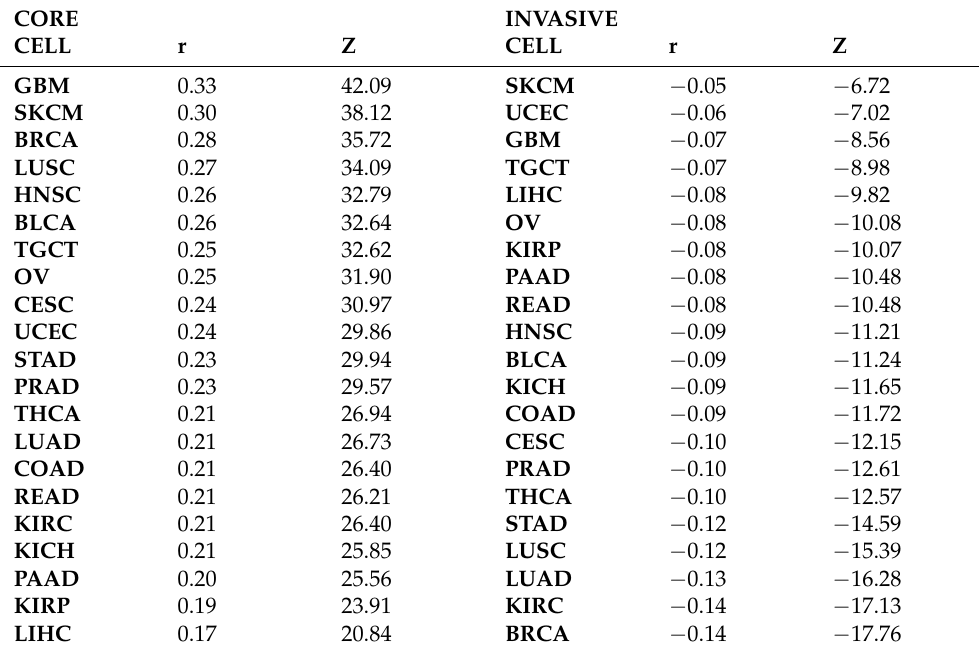
Table 1. The rank expression profiles for the untreated cells compared to a panel of cancer cell types from the TCGA database. The rank expression profile for the untreated core cells was queried against a panel of 17 cancer cell lines from the TCGA database. The Spearman rank correlation coefficient is shown together with the Z score significance level. It is clear that the core cells correlate best with the GBM cell line from the TCGA database, shown left. The invasive GBM cell population, at right, has no positive correlation with any of the cancer cell types, including